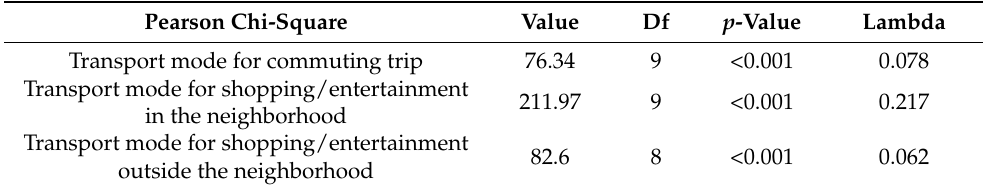
Table 4. Chi-square test for mode choice.